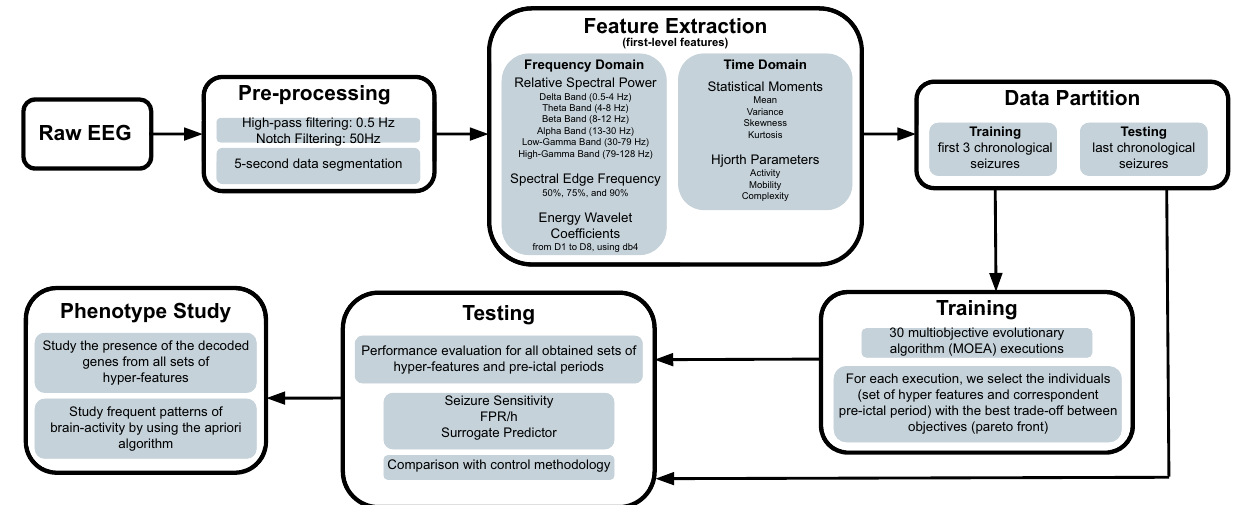
Figure 1. Flowchart of the proposed seizure prediction MOEA for each patient, comprising data processing, feature extraction, training, testing, performance evaluation and phenotype